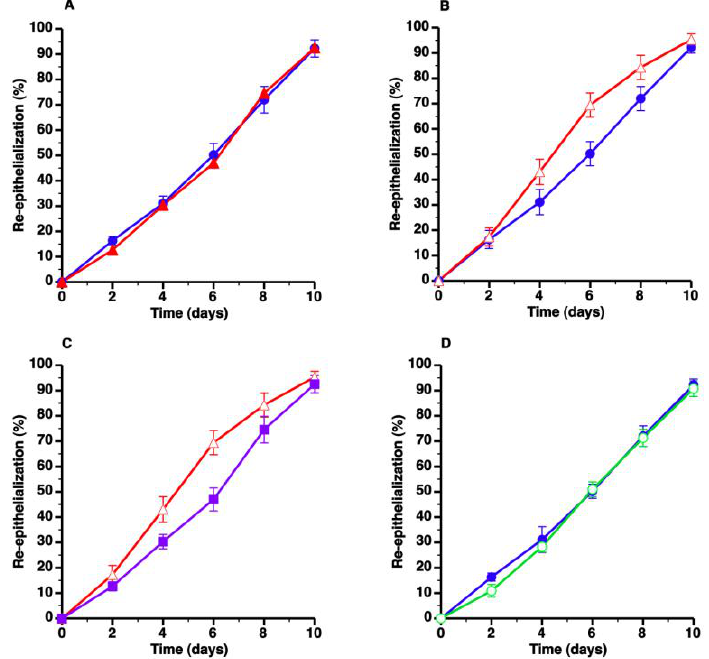
Figure 1. Evaluation of the effect of hypercholesterolemia on wound healing in C57BL/6 LDLr −/− mice. The different panels illustrate the time course of wound coverage by newly formed epithelium expressed as percentage of the original wound surface. Wounds were evaluated every two days from surgical creation of the wound until 10 days later. Panels A and B represent a comparison of C57BL/6 SC diet mice (  ) and C57BL/6 LDLr −/− SC diet mice (▲) and C57BL/6 LDLr −/− CC diet mice (Δ), respectively. The effect of AdLDLr gene transfer (  ) on re-epithelialization in C57BL/6 LDLr −/− CC diet mice is illustrated in Panel C . Panel D compares wound coverage by newly formed epithelium in C57BL/6 SC diet mice (  ) and C57BL/6 CC diet mice (  ). All data represent means ±